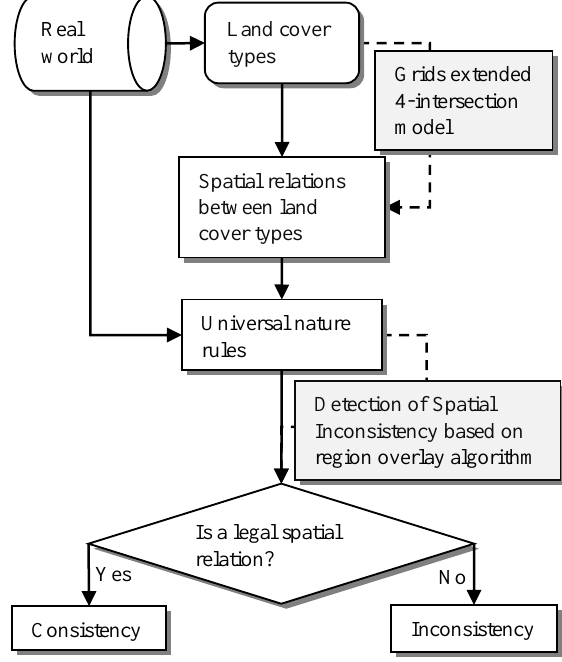
Figure 2. A framework for detection of spatial inconsistency.